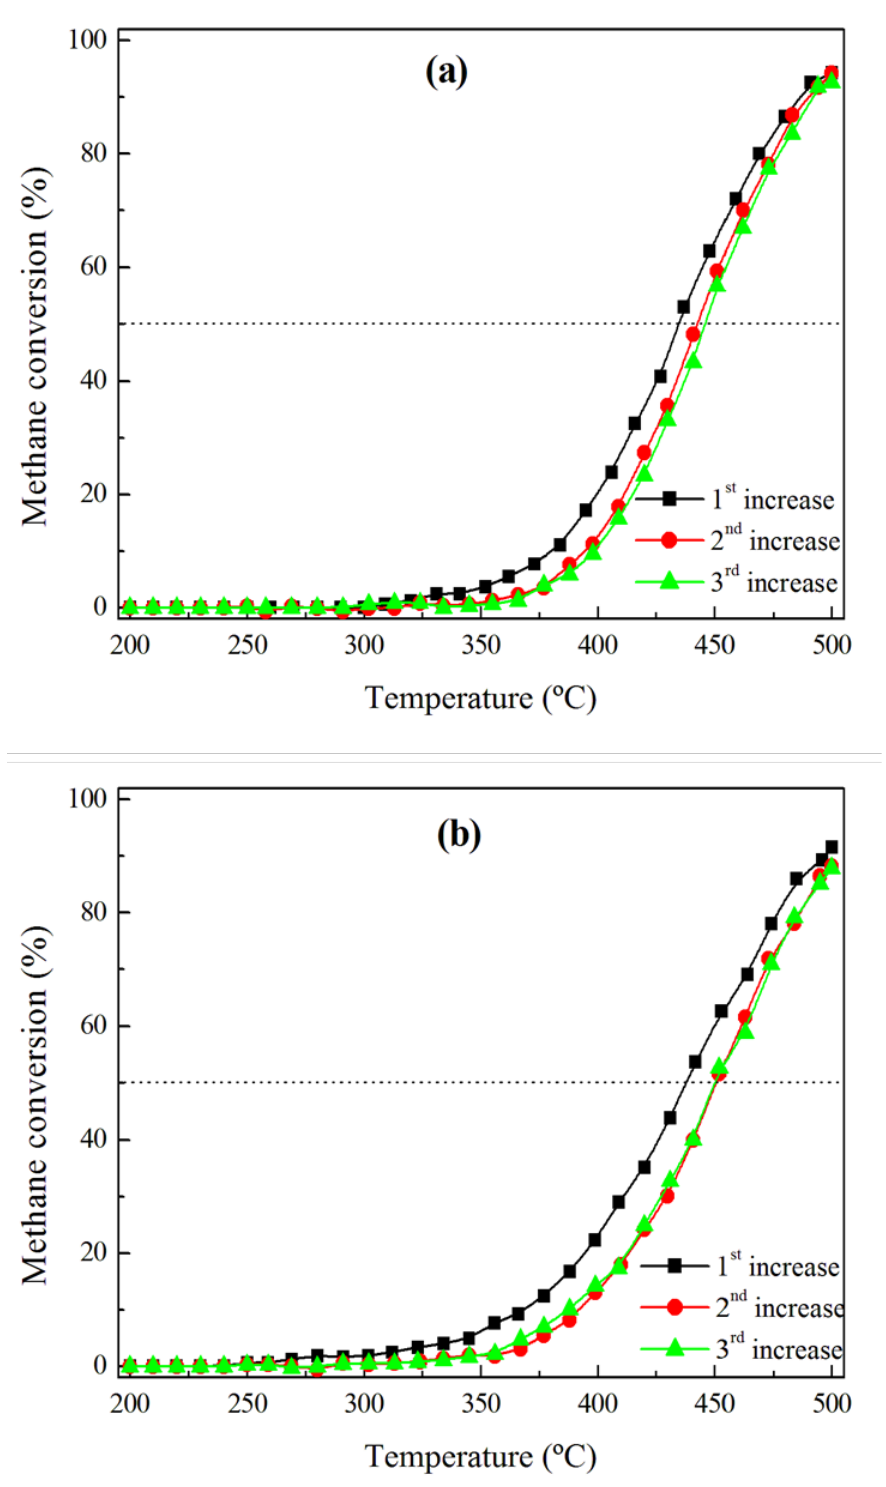
Figure 9. Activity of ( a ) Pd/HAP and ( b ) Rh/HAP catalysts submitted to three cycles of a realistic methane oxidation mixture: 1% CH 4 , 20% O 2 , 10% H 2 O, and 10% CO 2 .